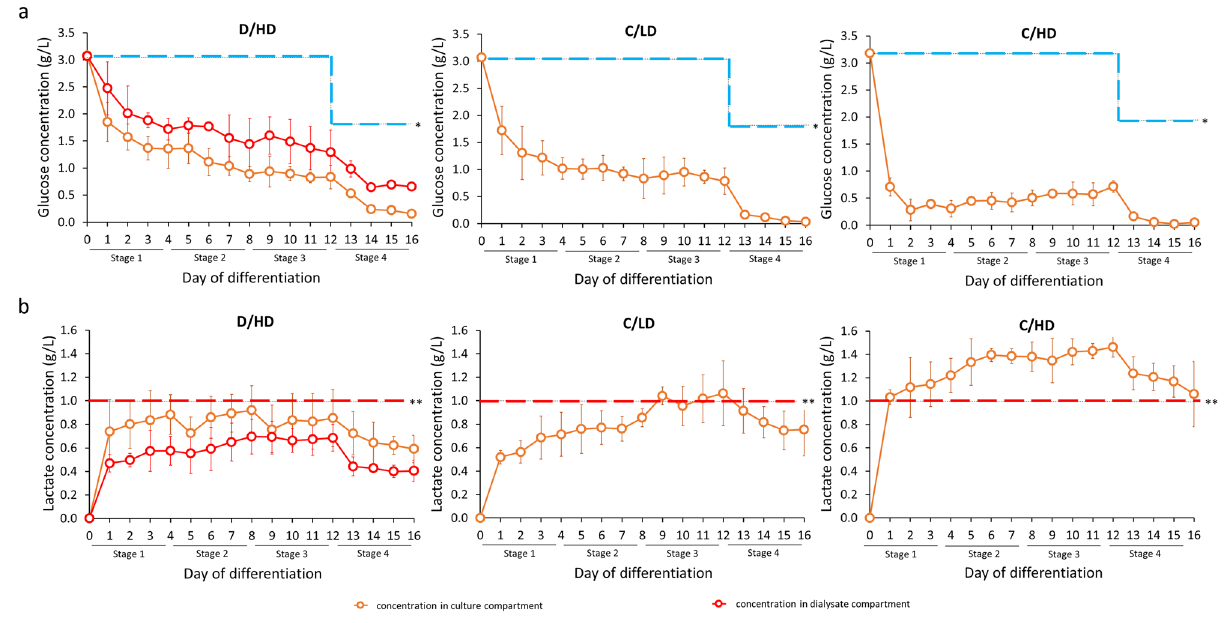
Figure 3. Glucose and lactate concentration in conditioned medium during differentiation. ( a ) The glucose concentration was sufficiently supplied by the dialysis culture system (D/HD). *The blue dotted line indicated the original glucose concentration in the culture medium. ( b ) The secreted lactate concentration was continuously removed and maintained below the critical limit of lactate accumulation that can impact viability. **This critical lactate concentration is based on the previous study by Horiguchi et al. 23 , indicated by the red dotted line. (n = 4 biologically independent